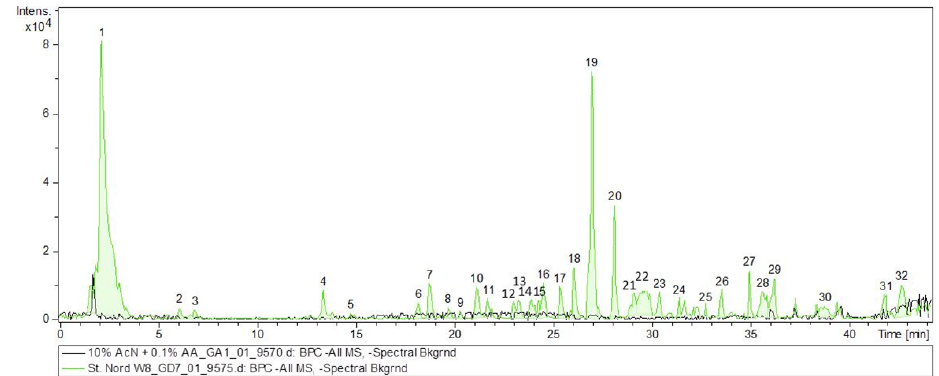
Figure 1. Chromatogram of the SOA sample from Station Nord week 8 (in green). A blank filter sample is shown in black. The SOA products giving rise to each peak are identified as follows: 1, sulphate dimer; 2 and 3, OS 140; 4, OS 154; 5, OS 196a; 6, terpenylic acid; 7, phthalic acid; 8, terephthalic acid; 9, pimelic acid; 10, unknown; 11 and 13, OS 168, 12 and 24, pinic acid; 14, OS 180; 15, DTAA; 16, unknown; 17, suberic acid; 18, unknown; 19, internal standard; 20, azelaic acid; 21 and 23, OS 182; 22, OS 208; 25, OS 250; 26 and 28, OS 196b; 27 and 29, unknown m/z 293; 30, OS 196b; 31, NOS 295; and 32. OS